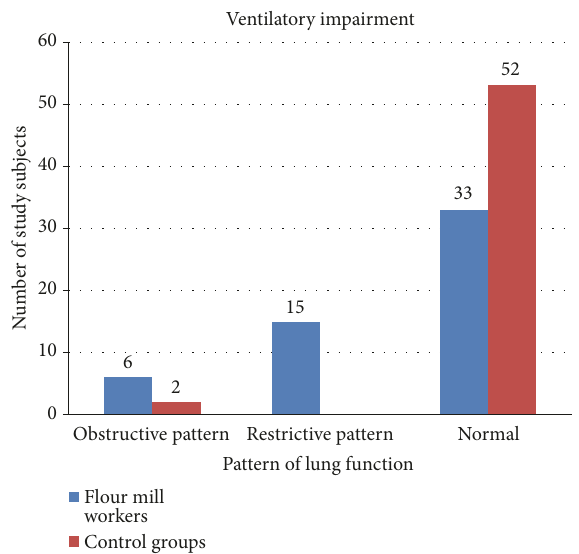
Figure 2: Bar chart showing the number of obstructive, restrictive, and normal patterns of lung function in controls and flour mill